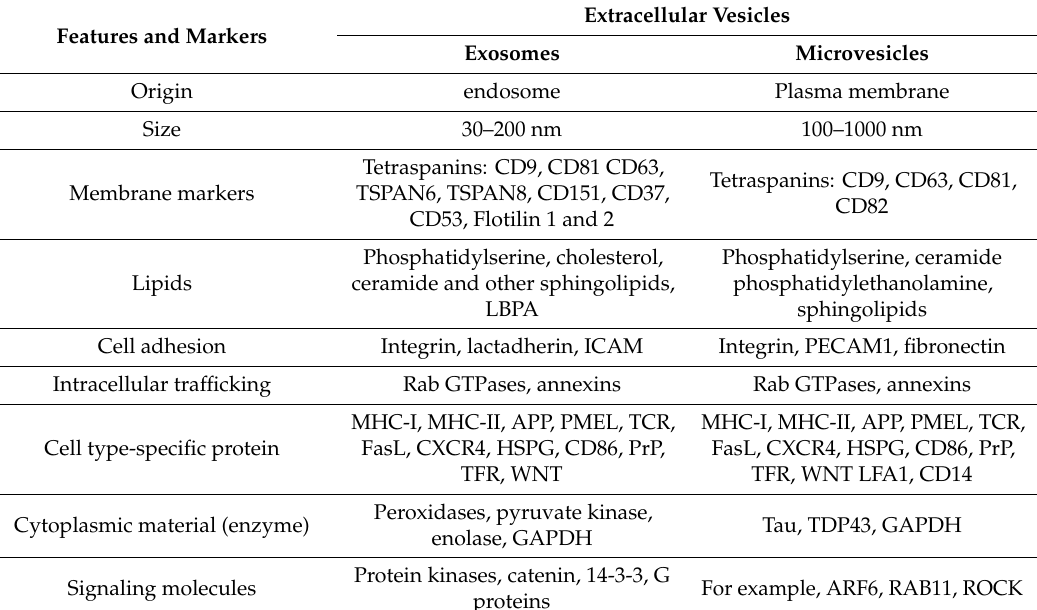
Table 1. Main characteristics of extracellular